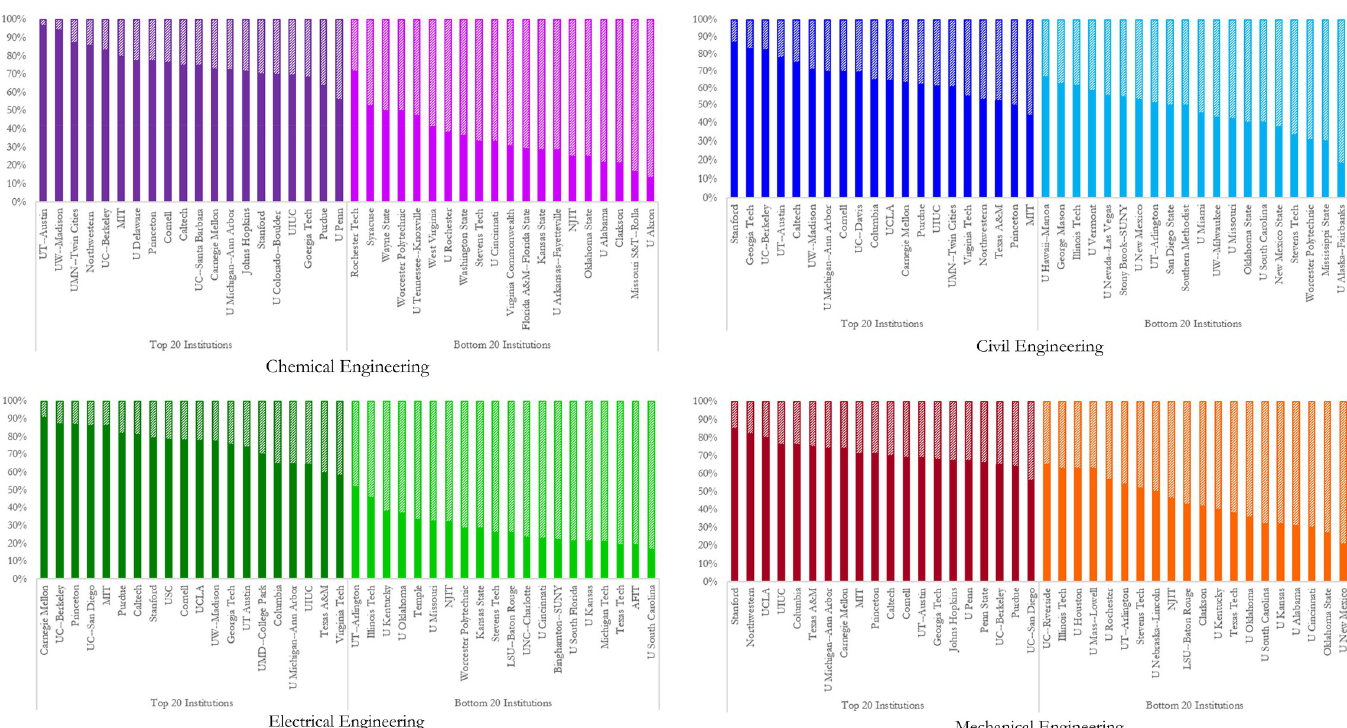
Fig 1. Distribution of faculty hires from top 20 ranked institutions over the top and bottom 20 ranked institutions. (A) Chemical Engineering, (B) Civil Engineering, (C) Electrical Engineering, and (D) Mechanical Engineering. Solid colors represent the share of hires from the top 20 ranked institutions, and the shaded color is representative of the share of hires not from the top 20 ranked